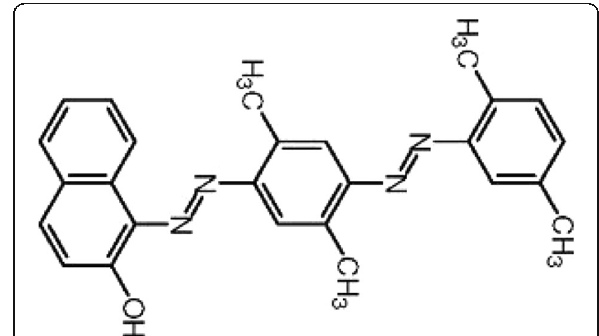
Fig. 1 Classification scheme to process different fractions of latent fingermarks Fig. 2 Structure of Oil Red O